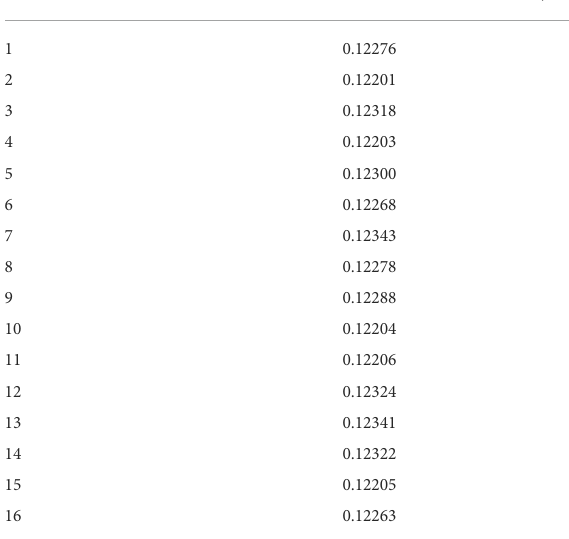
TABLE 2 Arrival-time matrix. TABLE 3 Time-difference